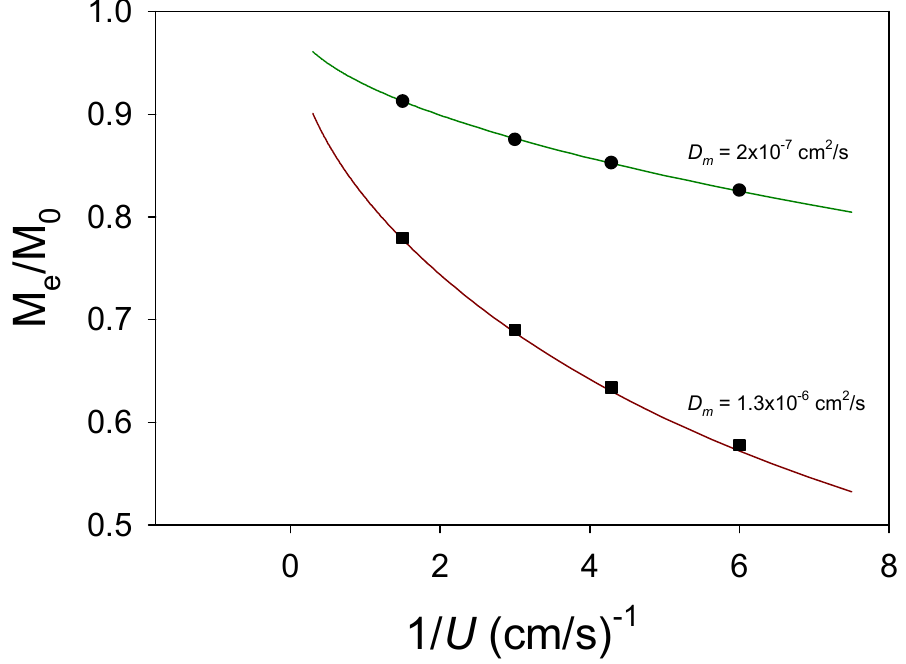
Fig. 2. Plot of the bolus outlet to inlet cumulative mass ratio (M e /M 0 ) versus inverse average velocity (1/U) for different values of diffusivity, D m . Solid lines are the analytical solution without dispersion. Squares and circles are numerical results with dispersion. Channel dimensions are as given